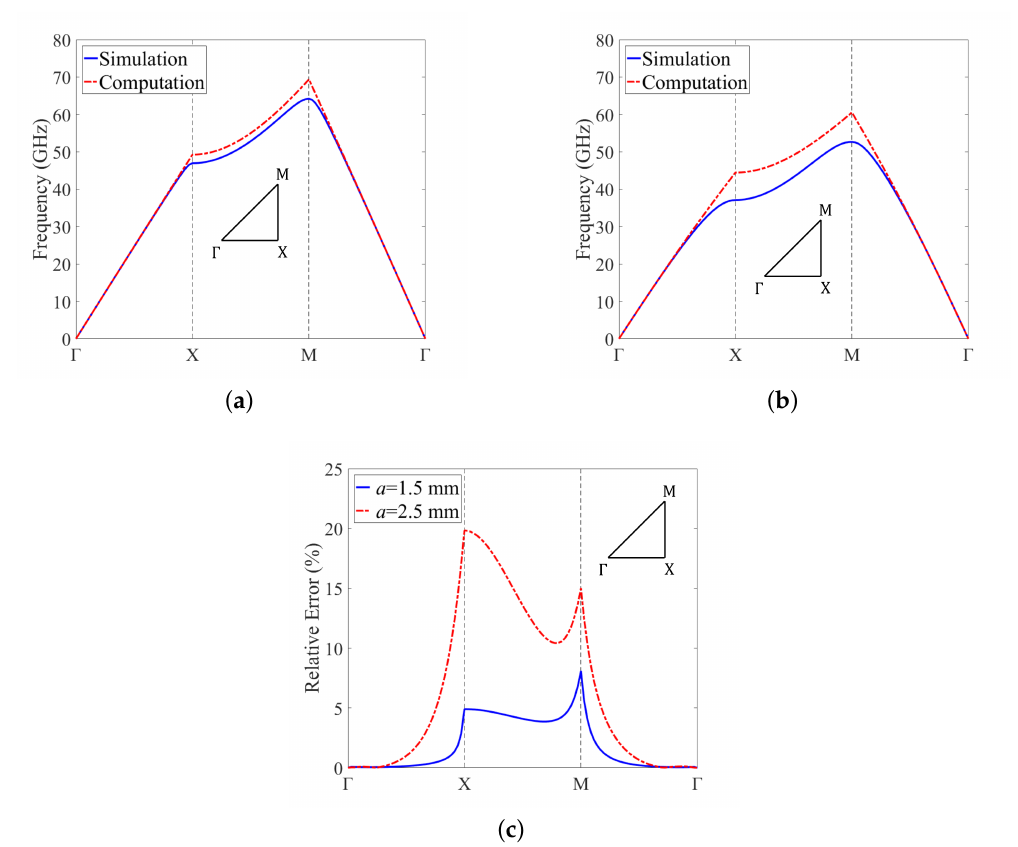
Figure 20. Comparison between the simulated and computed dispersion diagram for the impenetrable metasurfaces with different a : ( a ) a = 1.5 mm ( b ) a = 2.5 mm ( c ) relative